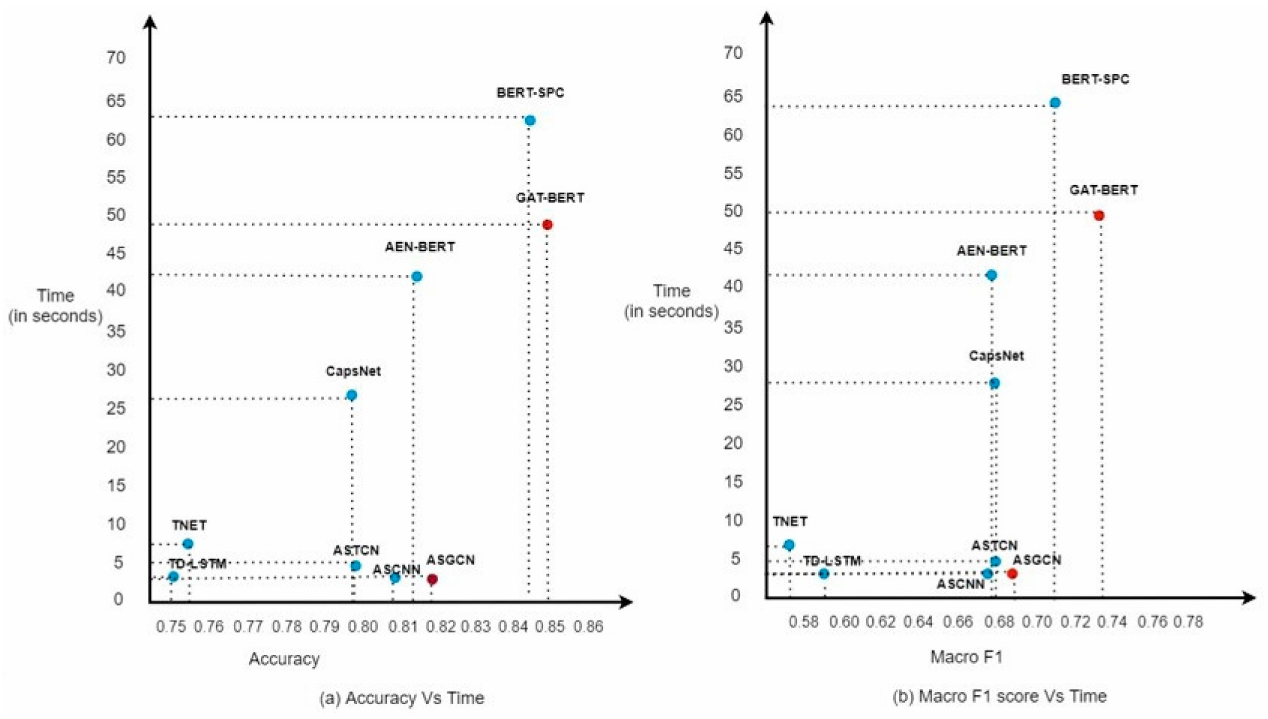
Figure 9. Pareto approach for selecting deep learning methods. Table 6. Wilcoxon Test results for pair-wise comparison of ASGCN and